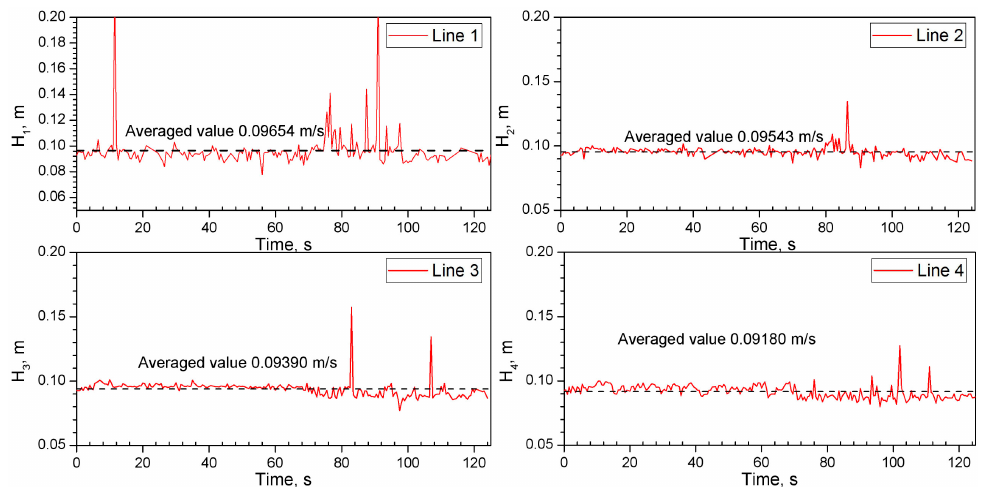
Figure 13. The time series of the slag–metal interface fluctuations at four typical positions of ( a ) line 1, ( b ) line 2, ( c ) line 3, and ( d ) line 4.